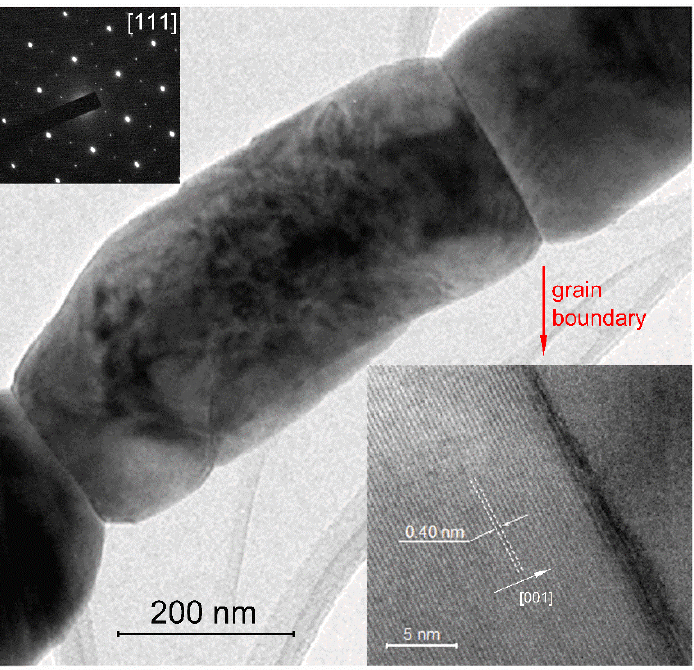
Figure 2. TEM images demonstrate two neck-separated single NKN nanocrystals. Upper inset presents selected area electron diffraction (SAED) pattern along [111] zone axes. High-resolution TEM image in lower inset shows the grain boundary between two adjacent nanocrystals.